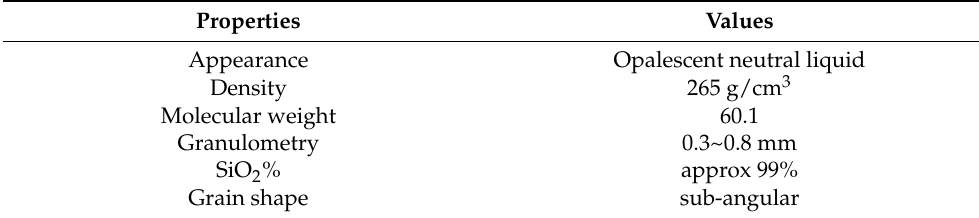
Table 3. Characteristics of silica